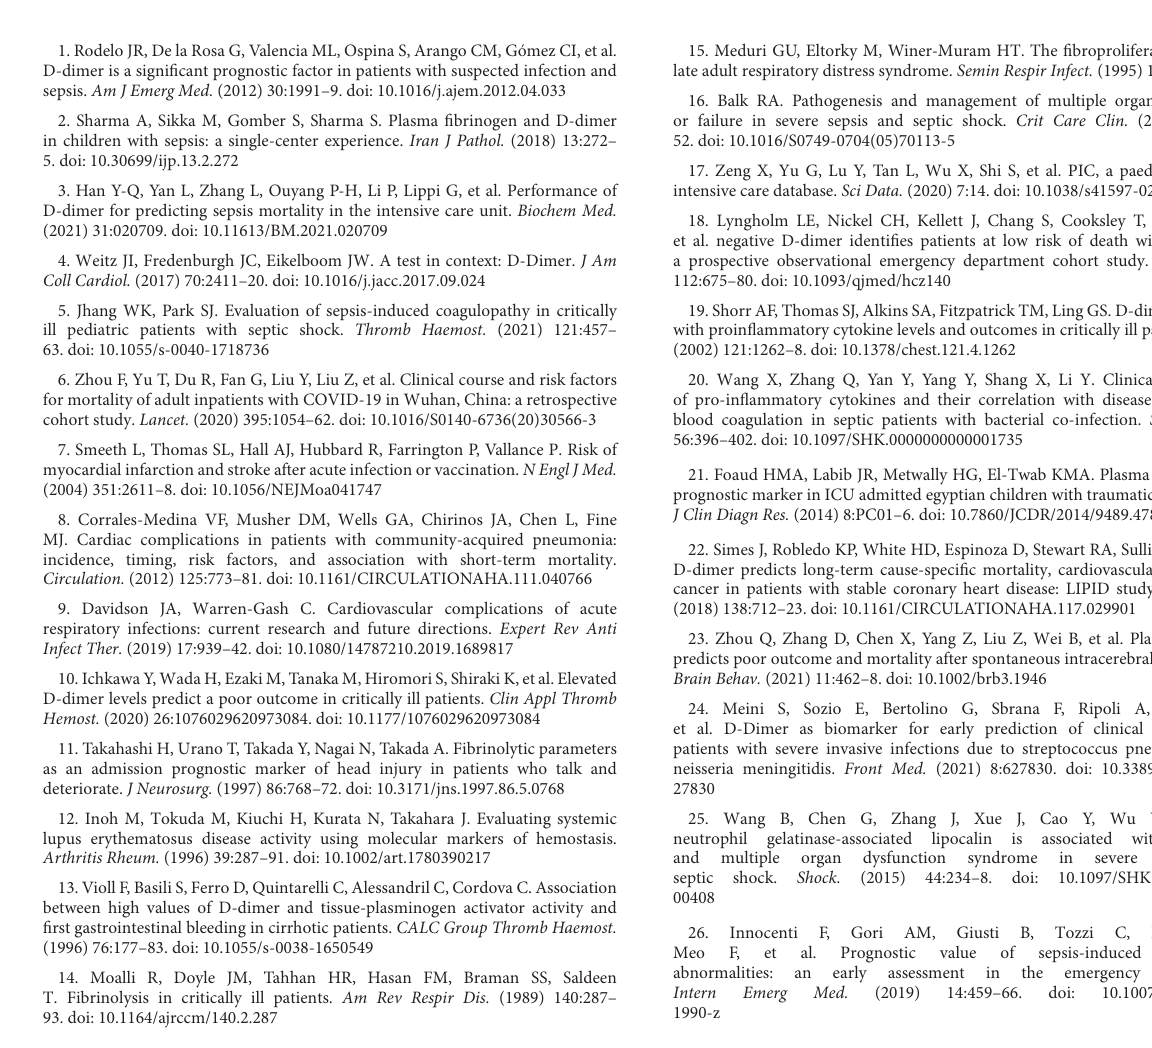
SUPPLEMENTARYFIGURE1 Non-linear cubic spline curve of D-dimer (A) , INR (B) , PT (C) , APTT (D) and Fib (E) against in-hospital mortality. The solid line represents the fitted line of the association between coagulation parameter and estimated OR of in-hospital mortality risk. The dotted line represents the upper and lower 95%